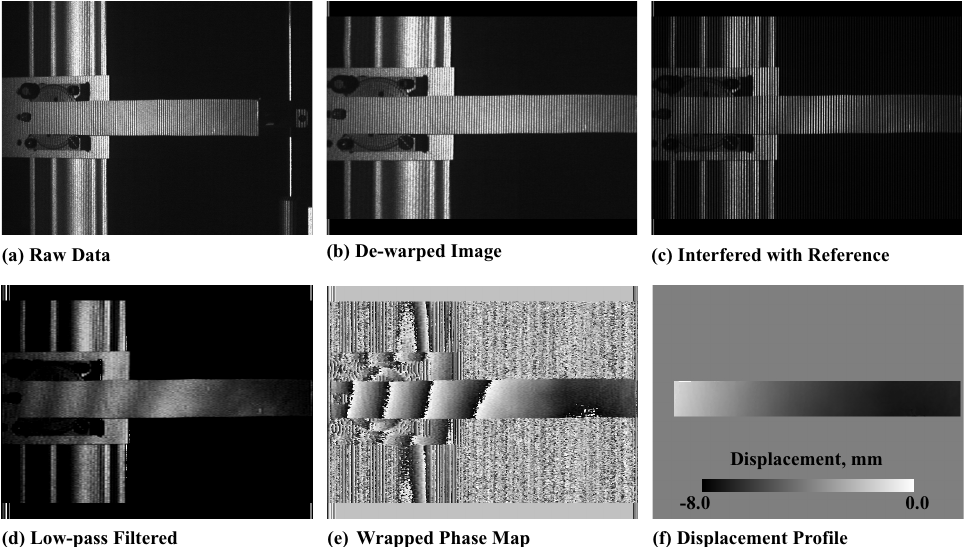
Fig. 3. PMI image processing steps.